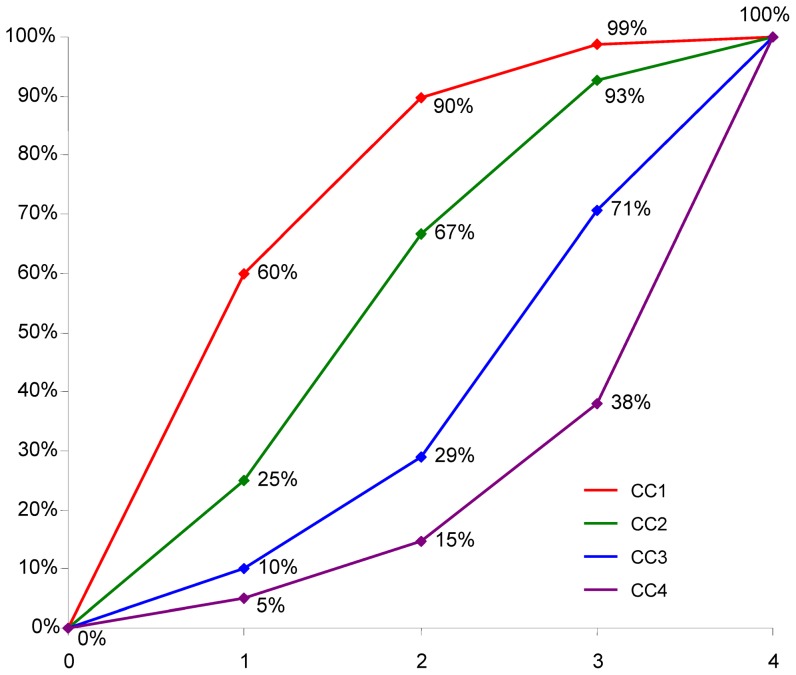
Prevalences by total number of diseases for four (thought up) chronic conditions (CC1 to CC4).